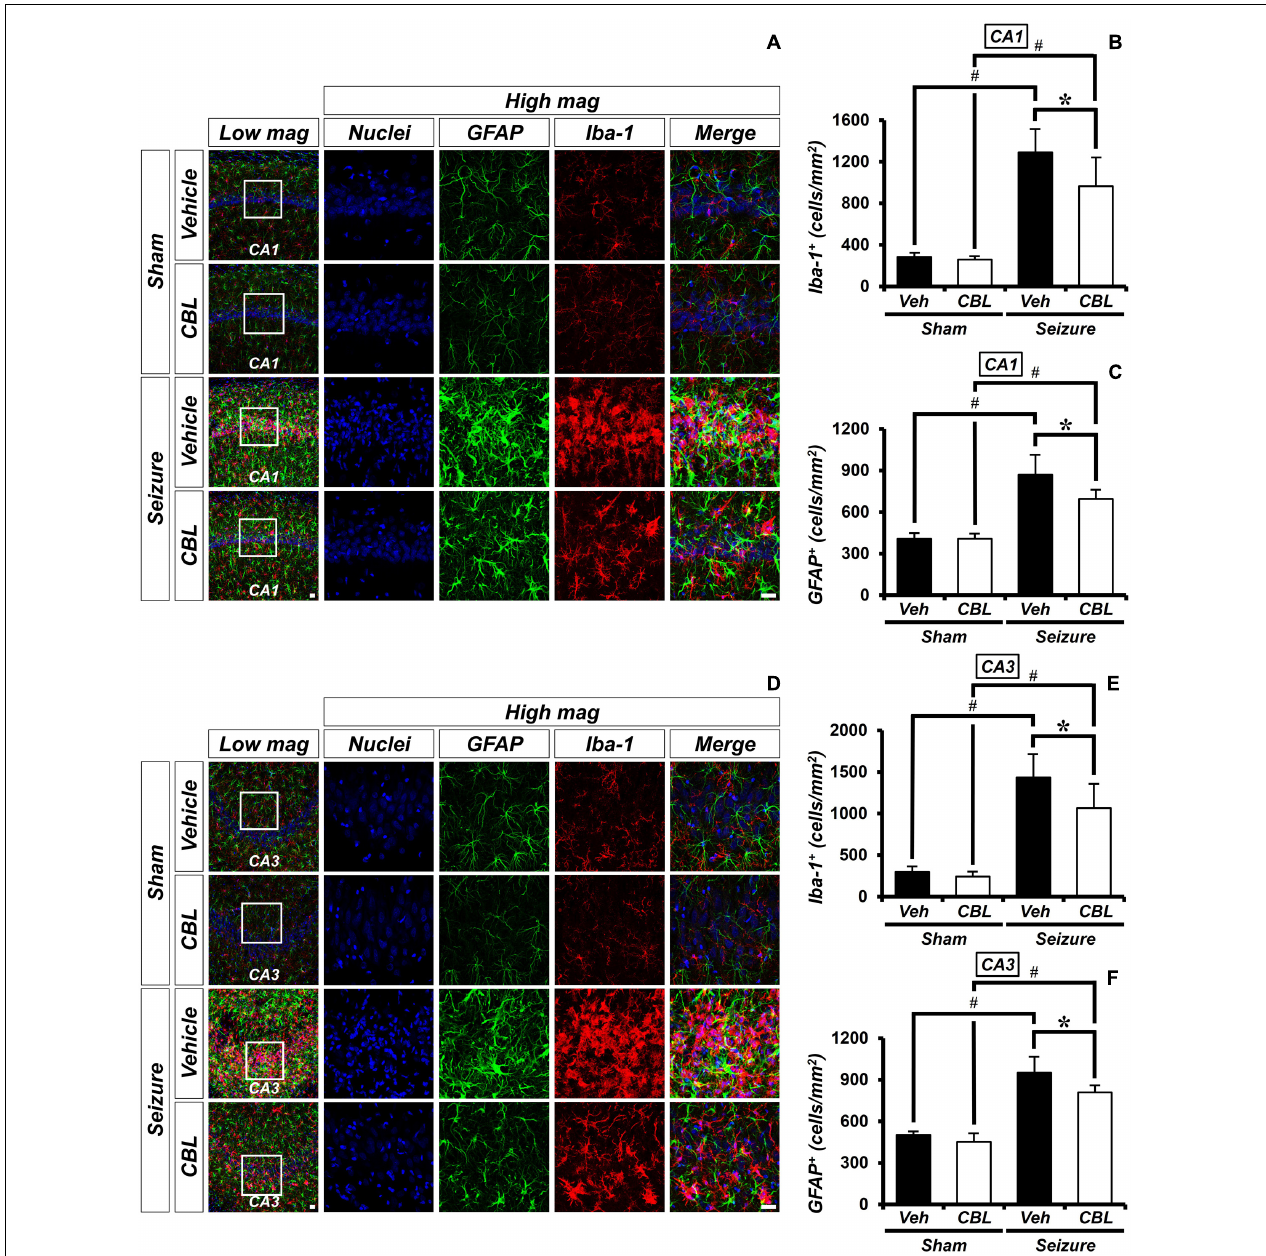
FIGURE 3 | Cerebrolysin decreases the density of glial cells after pilocarpine-induced seizure. The administration of cerebrolysin decreased the density of glial cells after pilocarpine-induced seizure. (A,D) Iba-1 (red), GFAP (green), and DAPI (blue) in the hippocampal CA1 (A) and CA3 (D) regions. The administration of cerebrolysin after a seizure decreased the density of glial cells in the hippocampal CA1 and CA3 regions compared to the seizure-vehicle groups. Scale bar = 20 µ m. (B,C,E,F) A graph of the density of glial cells according to the standard. The data are the mean ± SEM, n = 5, from each sham group; n = 5–7 for each seizure group. * p < 0.05 vs. vehicle-treated group; # p < 0.05 vs. sham-operated group [Kruskal–Wallis test with post hoc test: (B) Chi square = 17.244, df = 3, p = 0.001, (C) Chi square = 17.153, df = 3, p < 0.001, (E) Chi square = 17.456, df = 3, p = 0.001, (F) Chi square = 18.292, df = 3, p < 0.001].